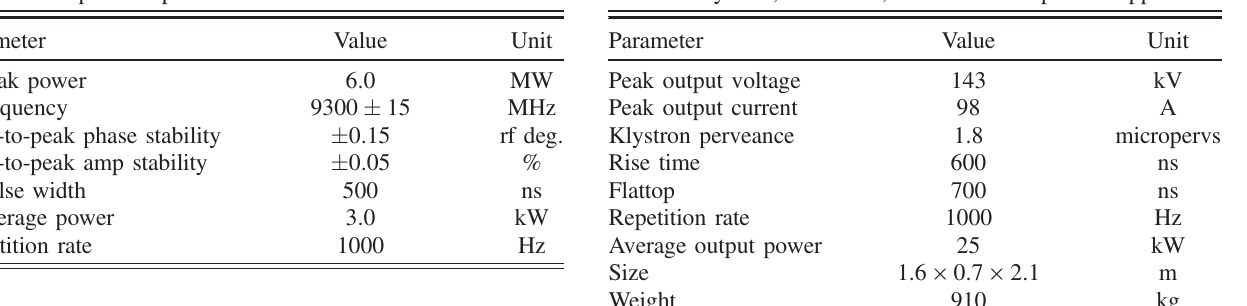
TABLE VI. Radio-frequency transmitter specifications. Stabil- ity values are pulse-to-pulse variation over a five-minute duration.